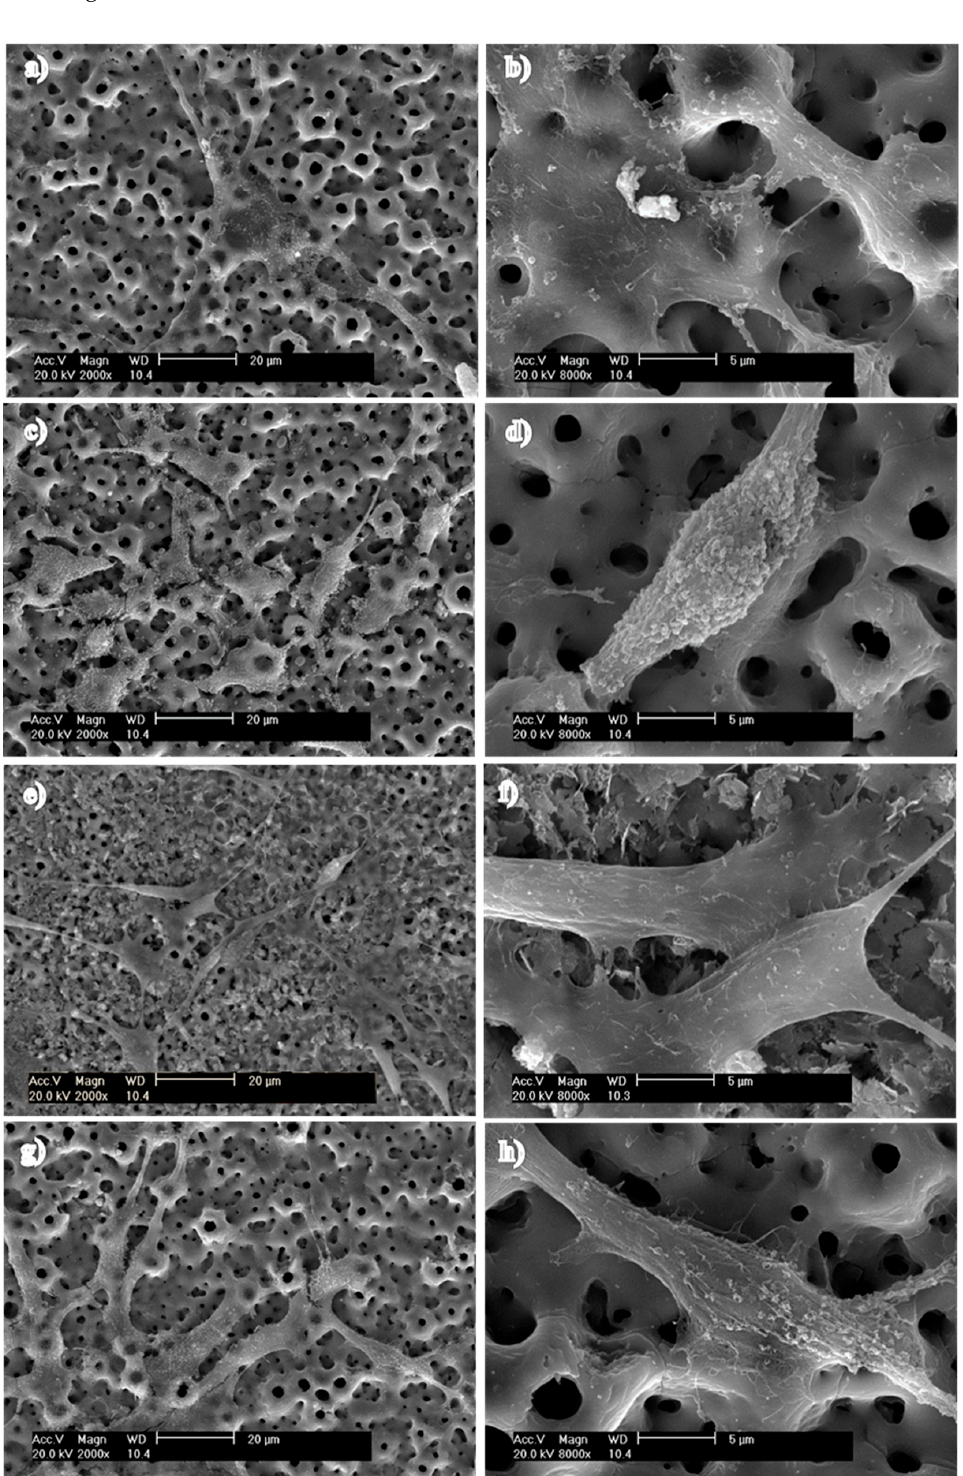
Figure 8. The surface morphology of MAO specimens with different N implantation doses after cell culturing for two days: ( a , b ) Ti-MAO-N0.1; ( c , d ) Ti-MAO-N1.0; ( e , f ) Ti-MAO-N5.0; ( g , h ) Ti-MAO-N20.